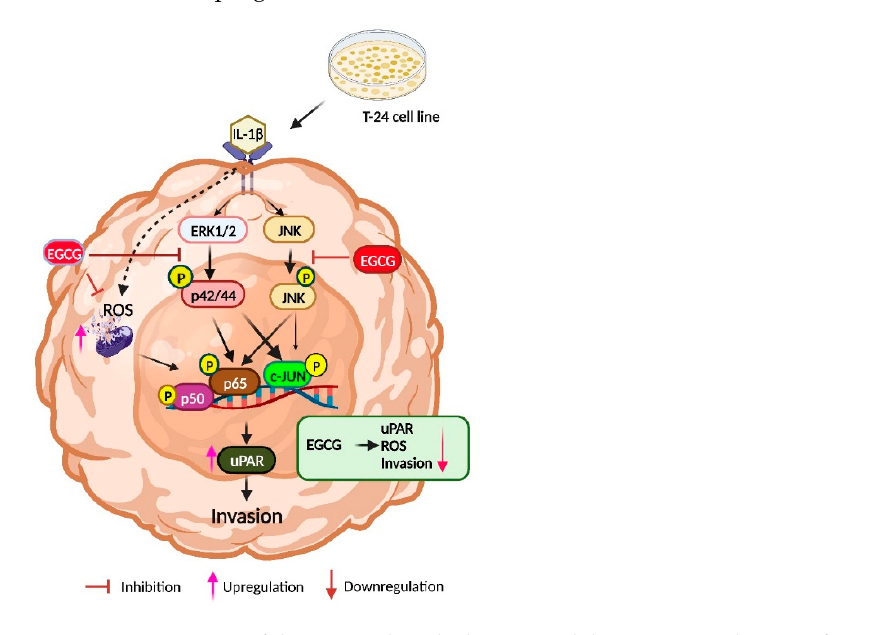
Figure 8. An overview of the process by which EGCG inhibits IL-1 β ’s induction of uPAR expression in T24 cells. By increasing uPAR expression, IL-1 β stimulates the invasion of T24 cells. Through the ERK1/2/JNK signaling pathways in T24 cells, IL-1 β stimulates the transcriptional activity of AP-1 and NF- κ B, which in turn promotes uPAR expression. By preventing the production of uPAR and attenuating the (ERK1/2, JNK)/AP-1 and (ERK1/2, JNK)/ NF- κ B signaling pathways, EGCG prevents the invasion of T24 cells that are triggered by IL-1 β .